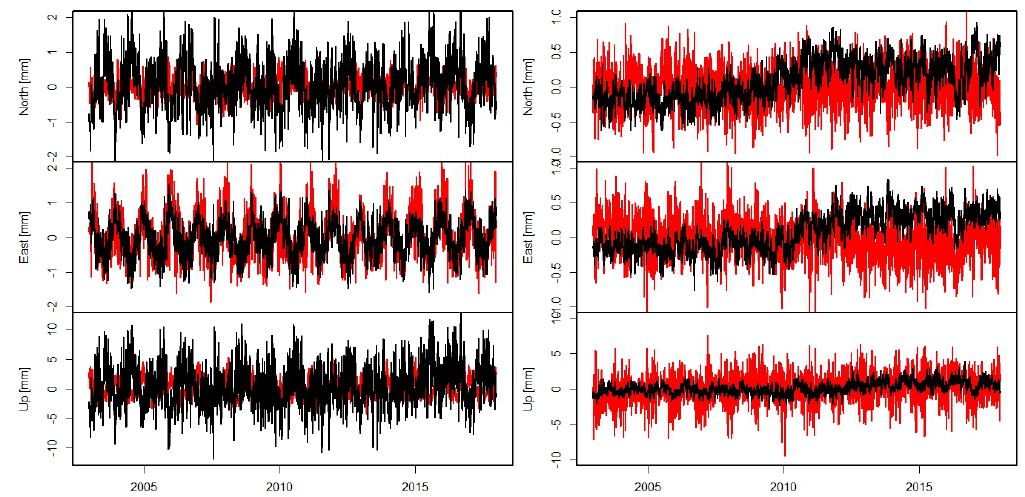
Figure 15. Environmental loading time series at Aboa between 2003–2017: atmospheric loading ( left ) and non-tidal ocean loading ( right ). The red curve is from GFZ loading service and black curve is from EOST. For more details, see the